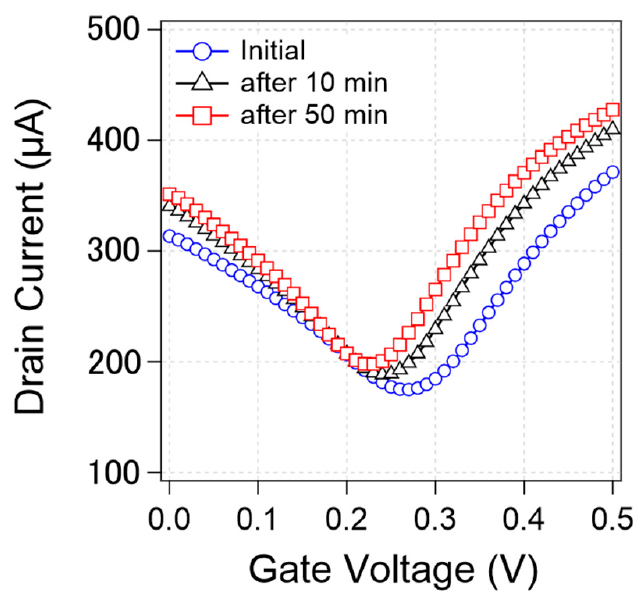
Figure 4. Change of transfer curves from a specific device during measurements. Initial transfer curve (blue circle) and the transfer curve after 10 min measurement (black triangle) and 50 min measurement (red square).